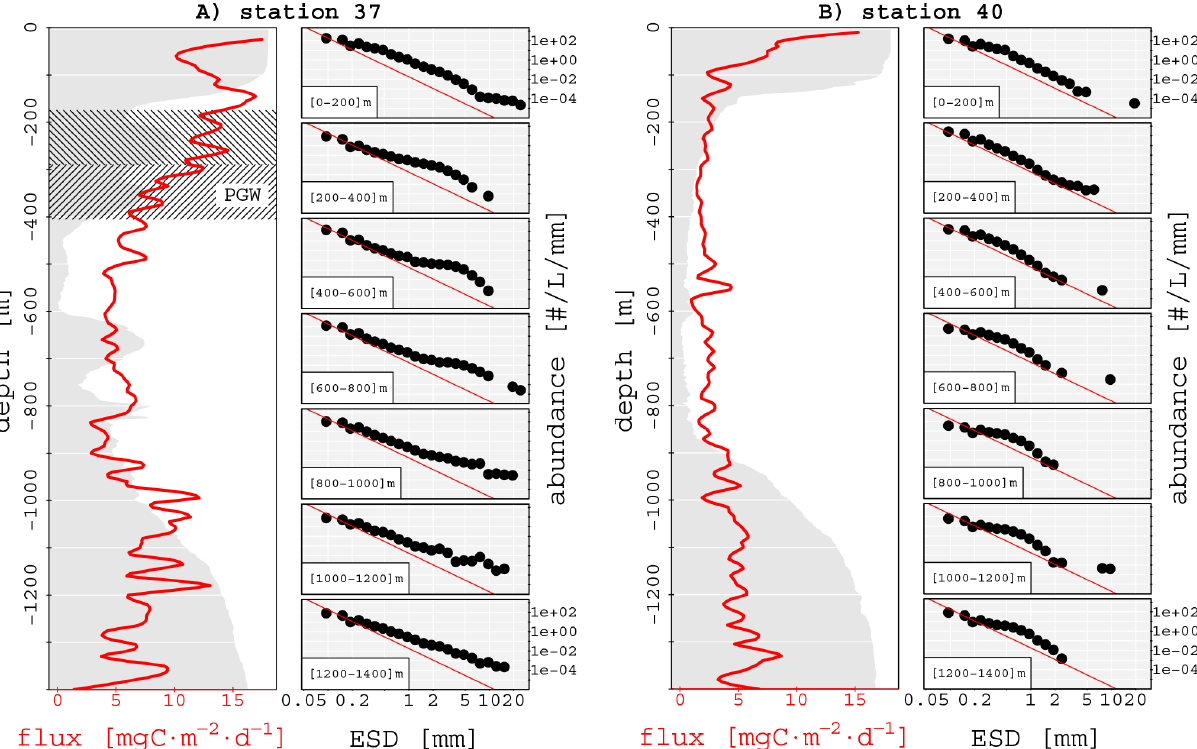
Figure 11. (A) Station 37, left panel: vertical profile of LPM fluxes with oxygen concentration background (grey colour, for units see Fig. 4). Right panel: PSD in increasing depth layers (each layer is 200m depth). The red line has a slope of − 4 and is given as a reference line for all PSD. (B) same as (A) for station